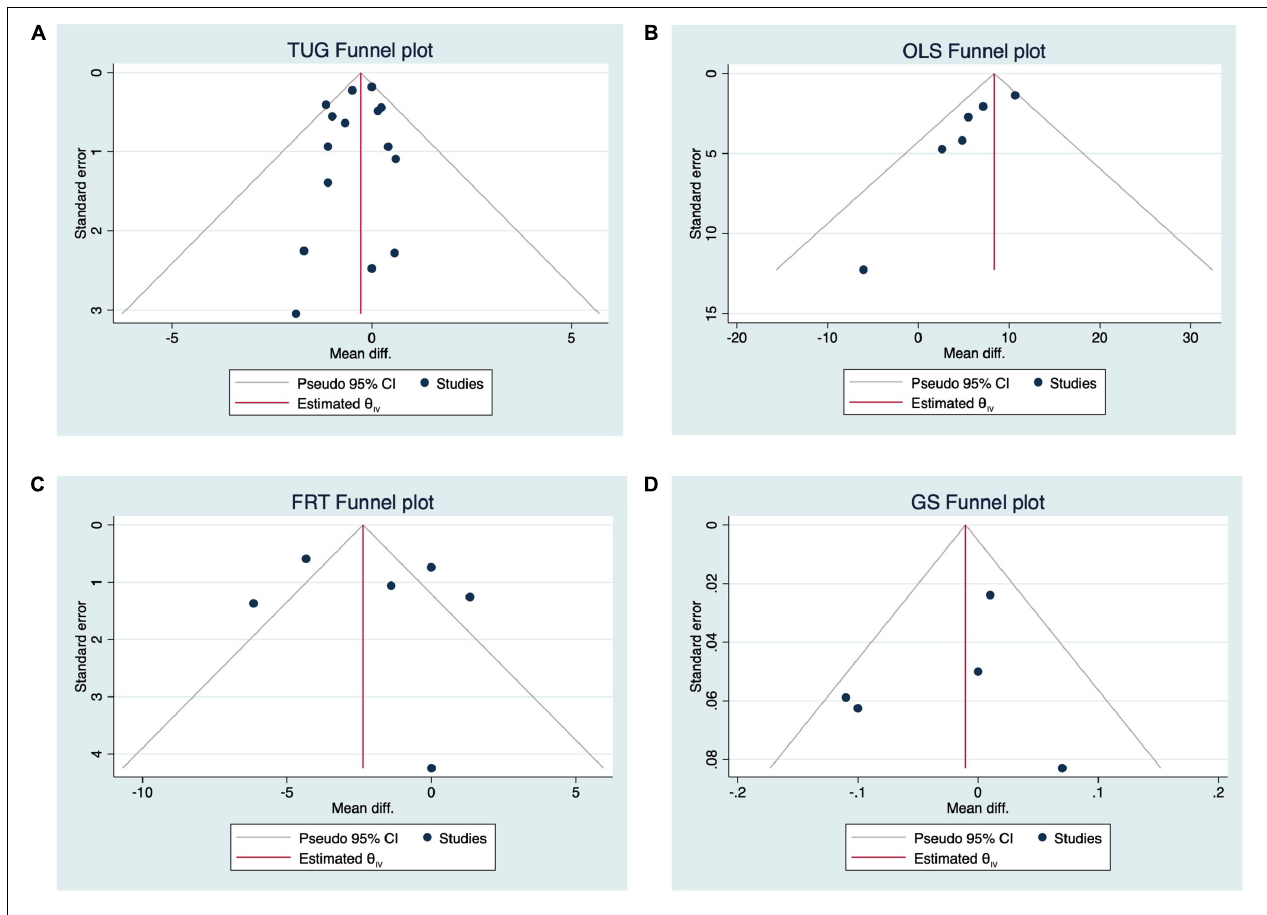
FIGURE 4 | Funnel